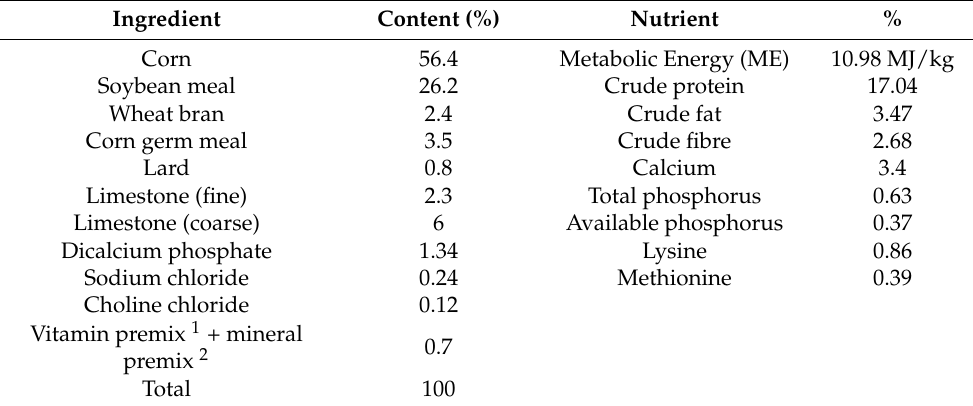
Table 1. Ingredient composition and calculated nutrient content of basal diet (% Dry